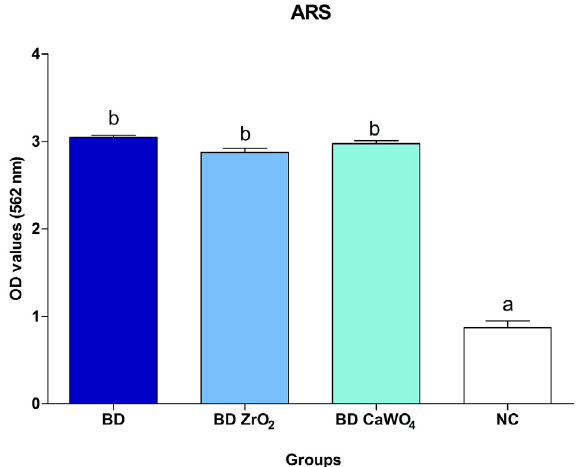
Figure 5- Alizarin red staining (ARS) assay. Comparison of mineralized nodule production after 21 days of cell exposure to BD, BD ZrO and BD CaOW extracts and negative control group. 2 4 All cements induced a greater mineralized nodule production when compared with the negative control group. Bars with different letters represent significant differences between groups. =BD with addition of 15% zirconium BD=Biodentine; BD ZrO 2 oxide; BD CaWO =BD with addition of 15% calcium tungstate; 4 NC=negative